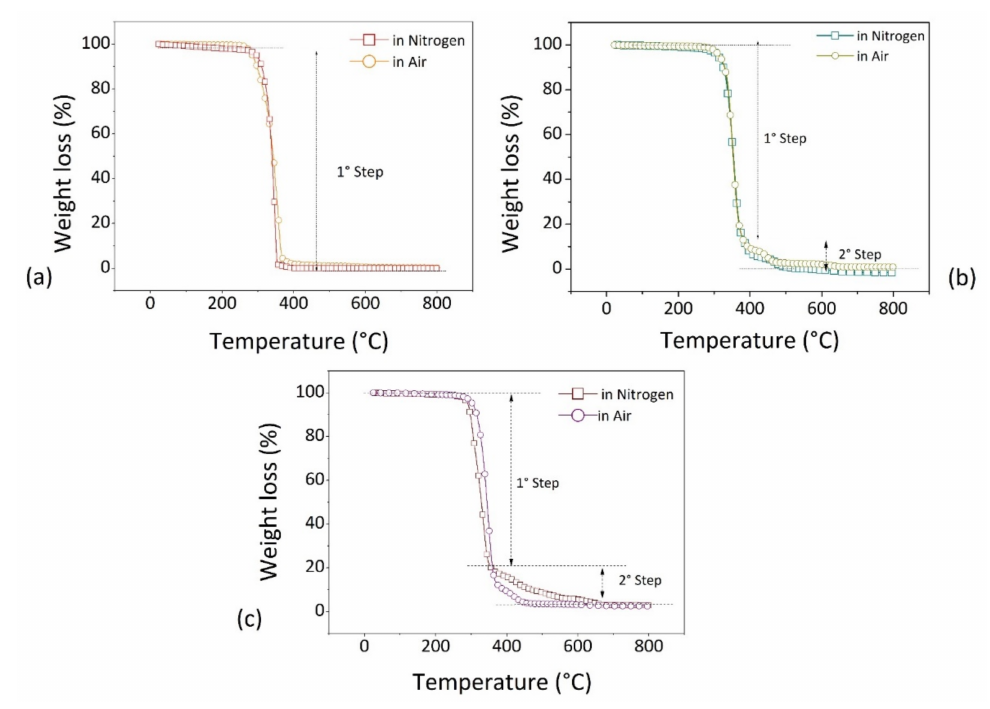
Figure 4. Thermograms of: ( a ) basic PLA; ( b ) Recycled PLA; ( c ) PLA+Wood filaments. Depending on the testing atmosphere, different thermal degradation phenomena can occur. In nitrogen atmosphere, pyrolysis develops through a series of reactions such as depolymerization, thermal cracking, and ring-opening. During pyrolysis, long macro- molecules are converted into other components with low molecular weights. In an oxygen environment, gasification and combustion take place and pyrolysis is reduced to substeps that produce primarily gas and char [45]. Most polymers burn in aerobic conditions and transforms in water (H 2 O), carbon dioxide (CO 2 ), and volatile components